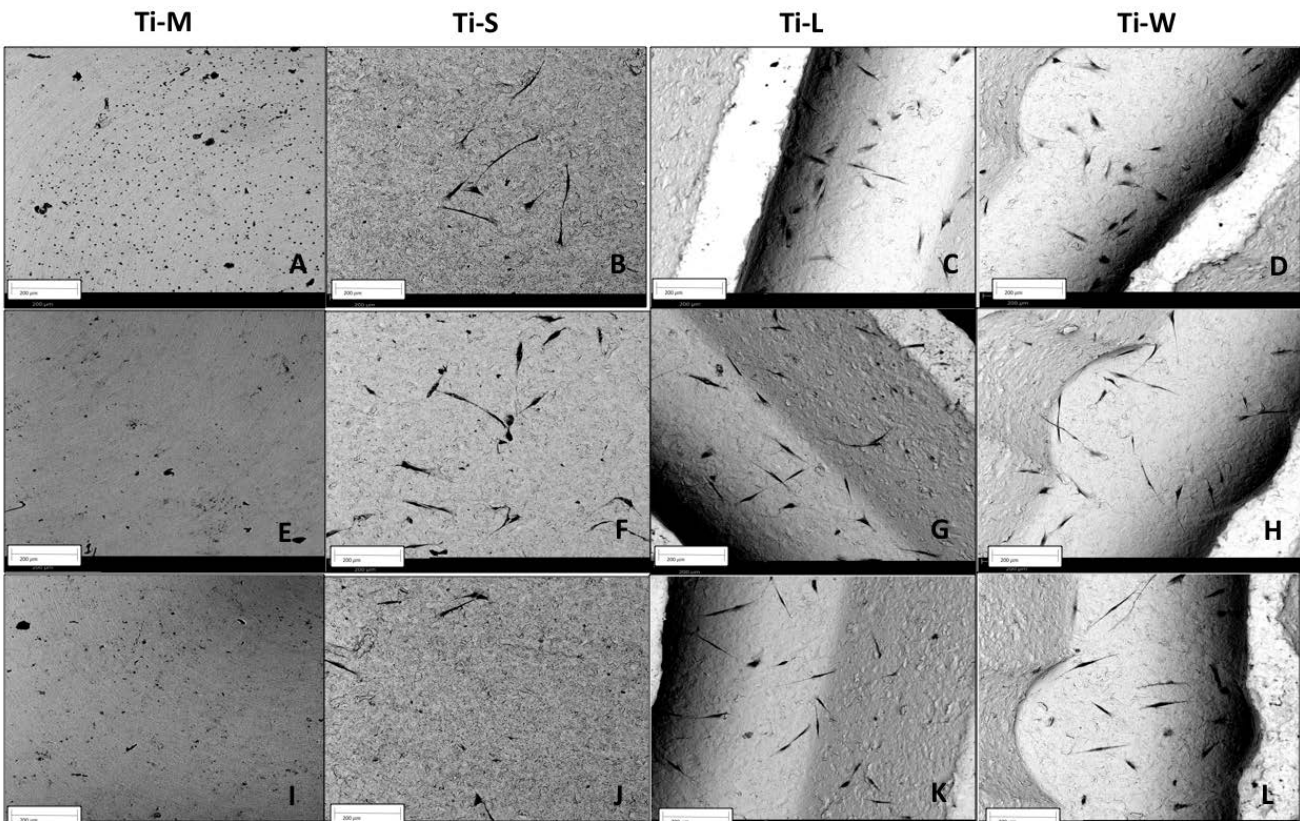
Figure 5. Morphology and adhesion of hGDFs on tested titanium surfaces at 290× magnification. Images show the round-shaped cells on Ti-M ( A , E , I ) and a visualization of filopodia spreading on sandblasted/dual-etched substrates: Ti-S ( B , F , J ), Ti-L ( C , G , K ), and Ti-W ( D , H , L ) at 1, 3, and 5 days, respectively. In addition to a typical morphology of fibroblasts, observed on TI-S discs, more cells remained adhered to the grooved structures covering the hollow portions of Ti-L and Ti-W surfaces. Especially at the fifth day, more adhered fibroblasts are observed on Ti-L (K) and Ti-W discs (L) with respect to the Ti-S surface (J). Scale bars: 200 μm. Images were taken using an accelerating voltage of 15 kV.